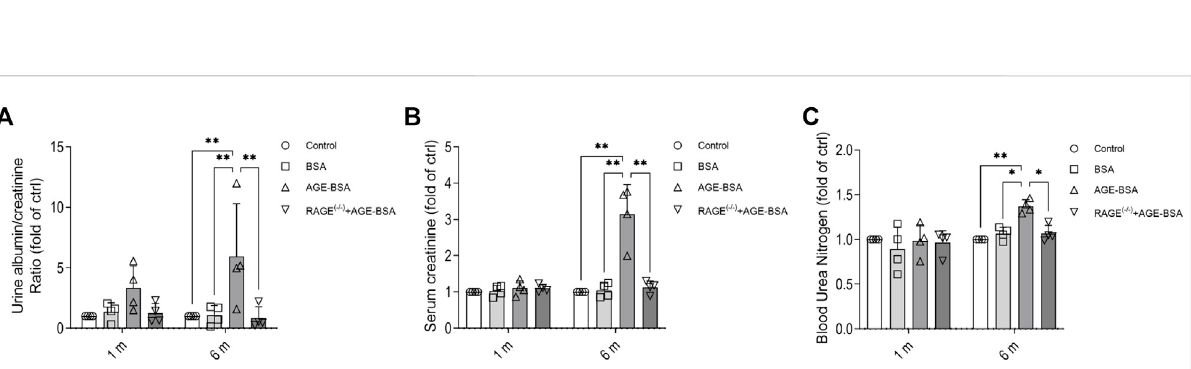
FIGURE 5 AGE-BSA induces RAGE-mediated renal dysfunction. The ratio of urine albumin to creatinine (A) was regarded as the level of albuminuria. Serum creatinine (B) and blood urea nitrogen (C) were also measured. n = 4, * p < 0.05, and ** p < 0.01.